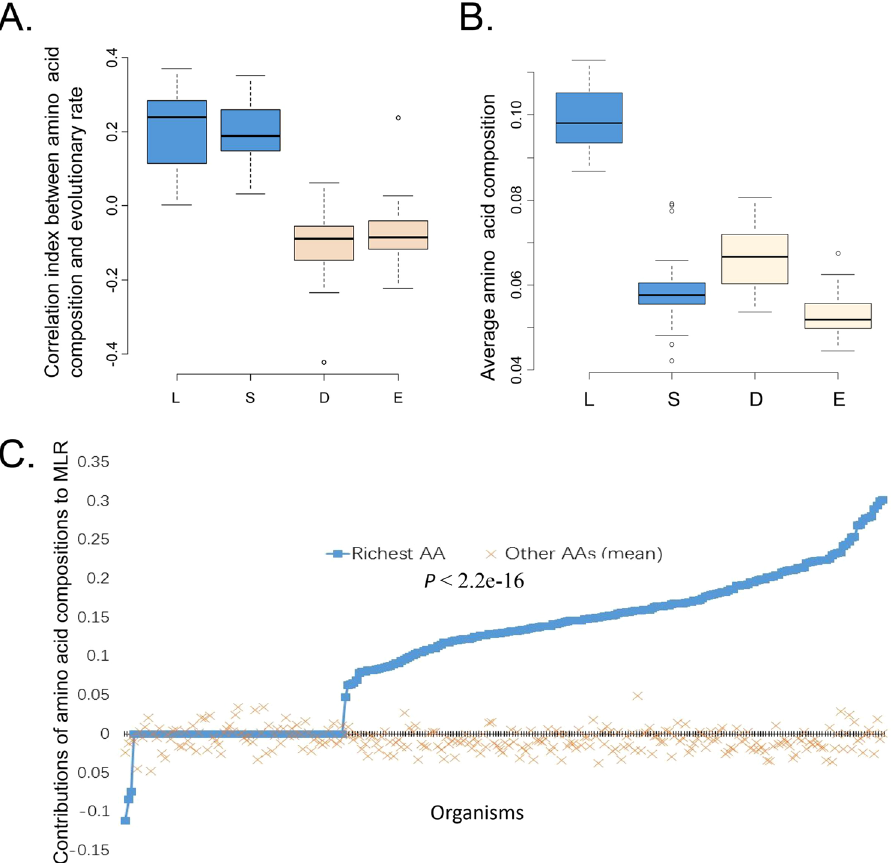
Figure 3. The amino acid composition and evolutionary rates. ( A ) The boxplot for the correlation index between amino acid composition and evolutionary rate in 56 genomes with GC content in range 45~55%. ( B ) The boxplot of the average amino acid compositions in 56 genomes with GC content in range 45~55%. ( C ) The scatterplot of contributions for 273 organisms. The horizontal axis represents organism. Each organism has two corresponding scatters: one is for the richest amino acids, and the other is for the rest amino